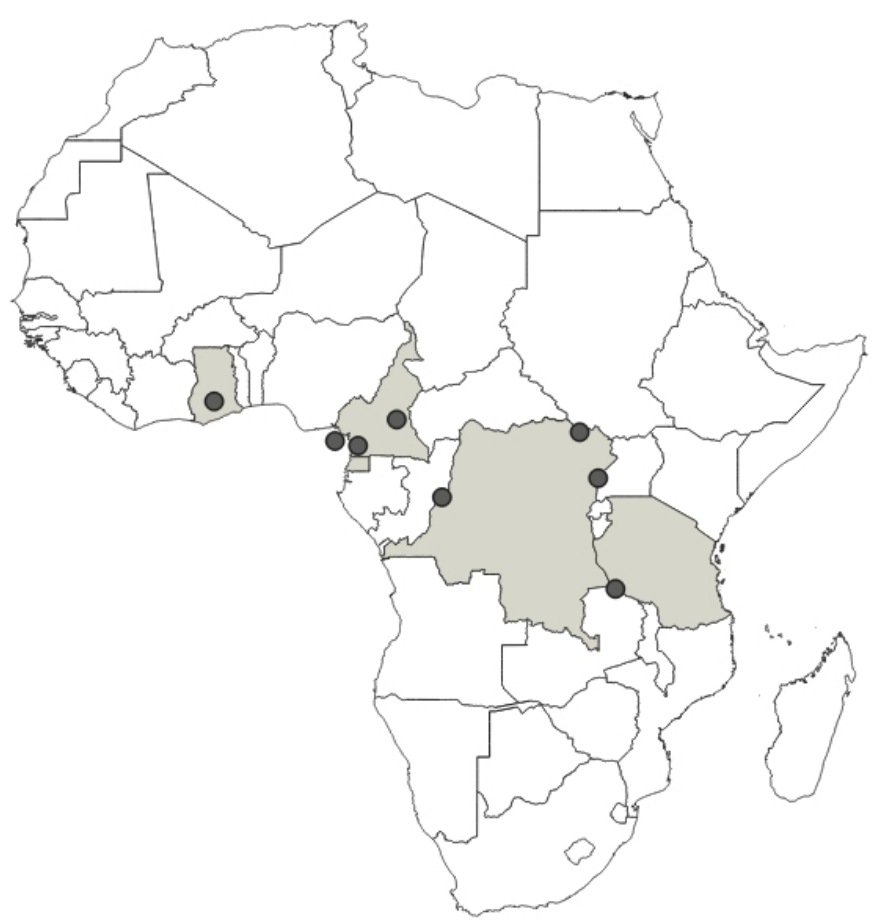
Figure 35. Known distribution of Phonoctonus caesar Haglund, 1895.